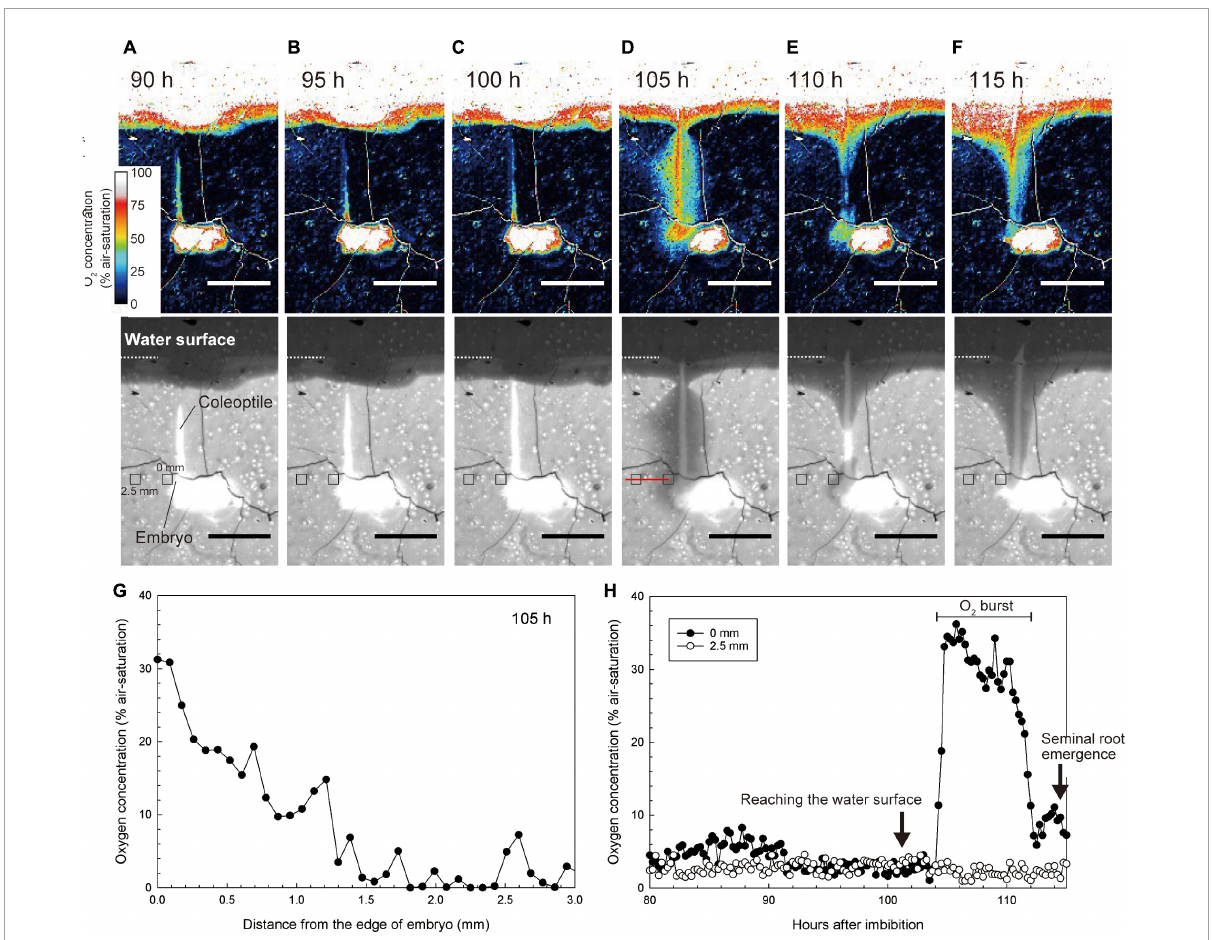
FIGURE4 Spatiotemporal O 2 dynamics under normoxic atmosphere. (A–F) An image sequence of the submerged germination process as recorded by the planar O 2 optode system. Bars = 10 mm. Upper color images are O 2 concentration images. Lower monochrome images are red images to visualize the growth of coleoptile. At the 101 h after imbibition, the coleoptile tip reached the water surface. The coleoptile tip was submerged in (A–C) or above water in (D–F) . Note: the O 2 value on the seeds and the coleoptile erroneously appear constantly high (i.e., over 50–100% air-saturation) due to a scattering artifact reflecting the white colors of seeds and coleoptiles. (G) O 2 gradient toward the embryo at 105 h